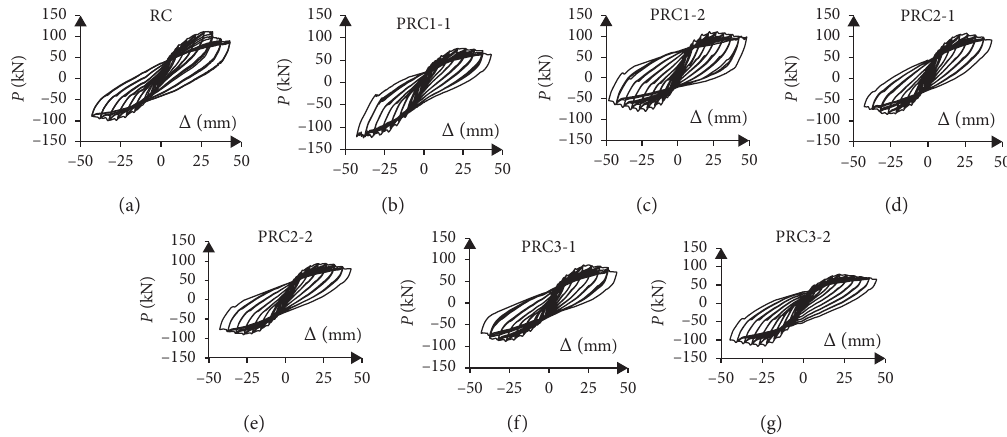
Figure 8: Hysteresis curves of horizontal load and displacement ( P − Δ ) of specimens: (a) specimen RC, (b) specimen PRC1-1, (c) specimen PRC1-2, (d) specimen PRC2-1, (e) specimen PRC2-2, (f) specimen PRC3-1, and (g) specimen